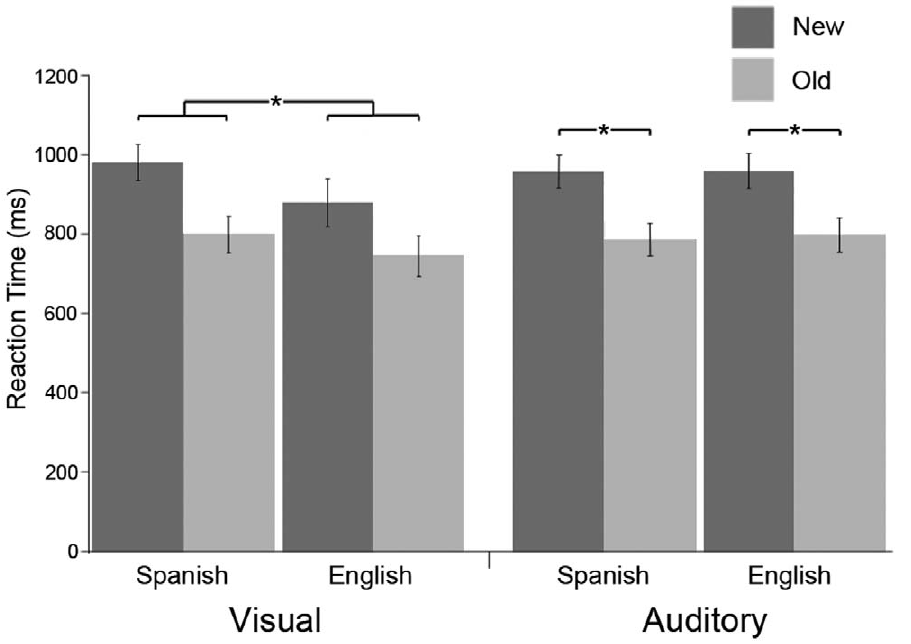
Figure 1. Mean reaction times for 16 subjects. Subjects responded faster to old words in both languages and modalities, and responded faster to English words in the visual modality. Error bars represent the standard error of the mean.